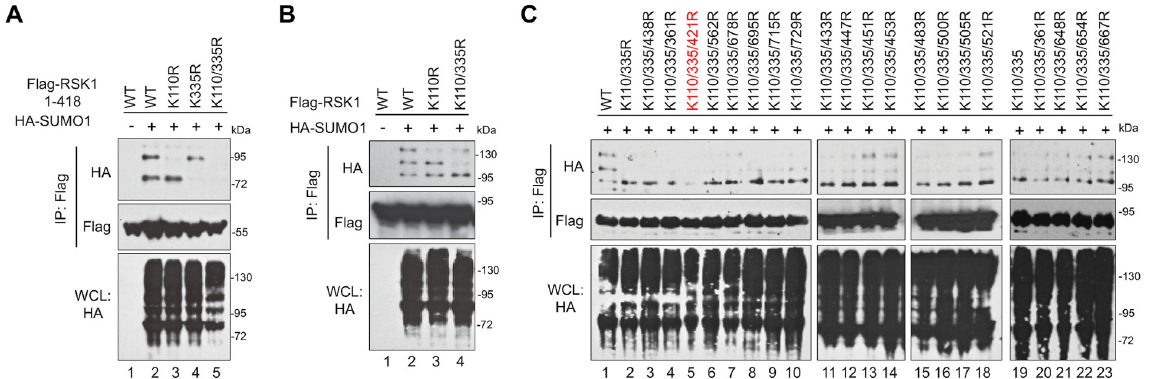
Fig 2. Identification of RSK1 SUMOylation sites. ( A ) Lys 110 and Lys 335 of RSK1 are two primary SUMOylation sites in RSK1 N-terminal fragments. HEK293T cells were co-transfected with indicated plasmids and cell lysates were subjected to IP and IB with indicated antibodies. ( B ) Lys 110 and Lys 335 are two SUMO sites of RSK1. Similar procedure as in Fig 2A. ( C ) Lys 110 and Lys 335 , and Lys 421 are three major SUMO sites of RSK1. Similar procedure as in Fig